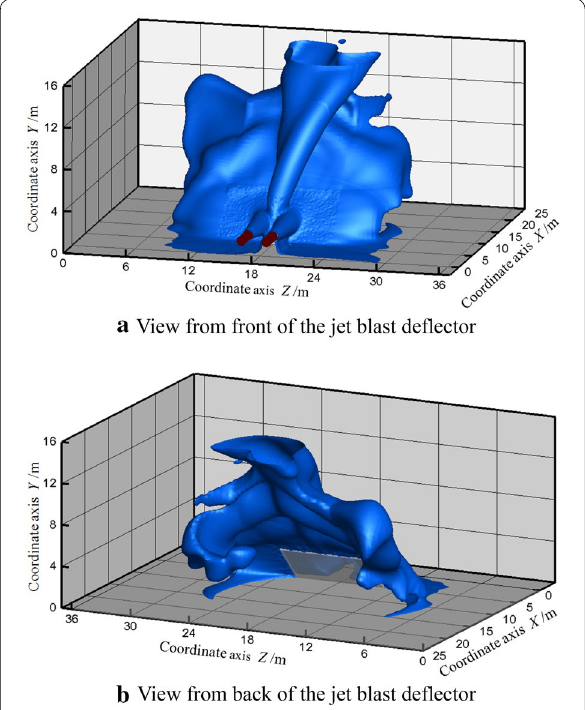
Figure 20 Static temperature contour of 116 °C in computational